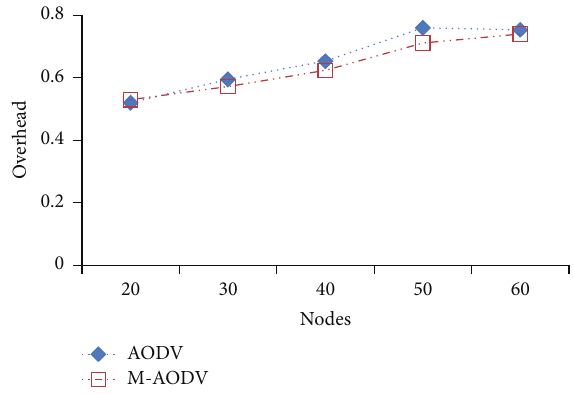
Figure 12: Overhead under black hole